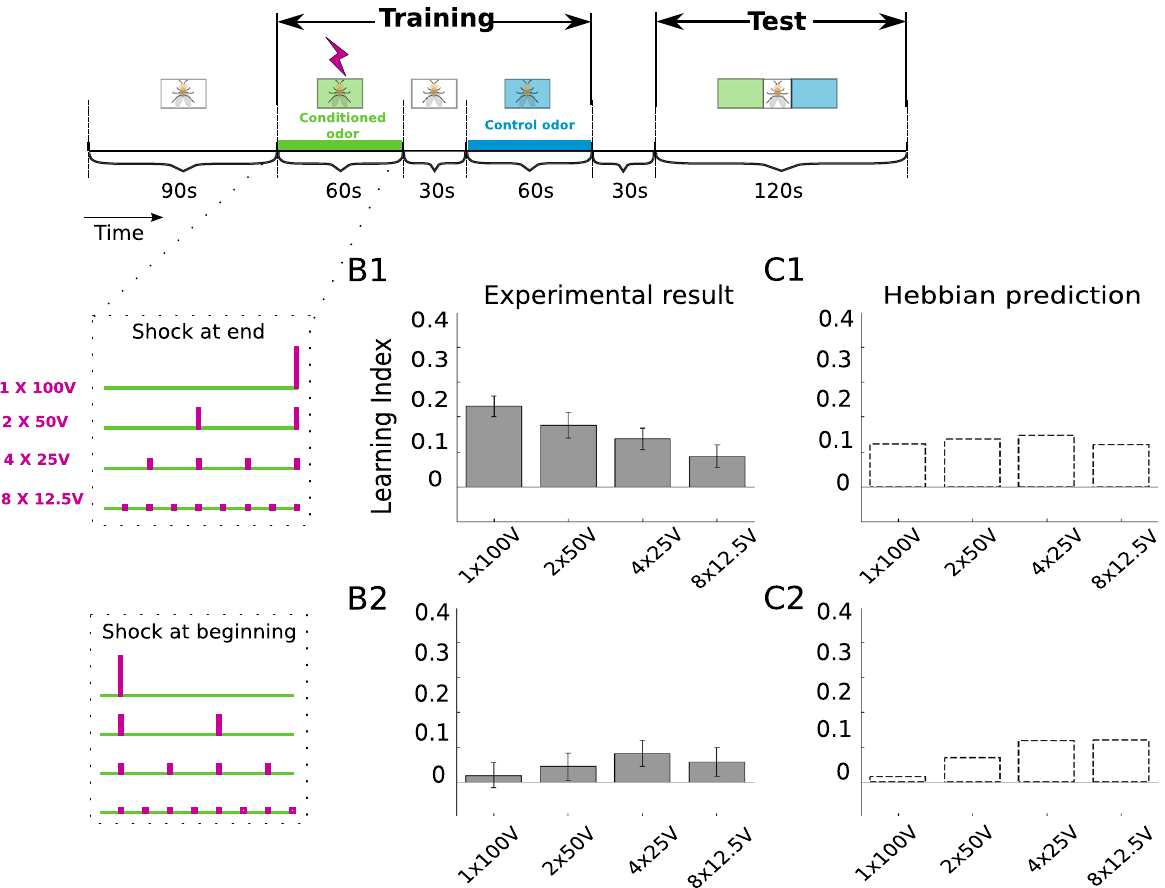
Figure 2. Temporal sequence conditioning is not fit by Hebbian plasticity. (A) Experimental protocol as explained in the main text, with total shock strength of 100 V distributed in time across the 60 s exposure to the conditioning odor (alignment towards the end, A1 , and towards the beginning, A2 ). The duration of an individual voltage shock (a magenta vertical bar) is 1.5 s. (B) Experimental results showing the LI for the corresponding shock distributions in A1 and A2 , respectively. For shocks at the end, the LI decreases with decreasing individual shock strength. Error bars represent the standard error of the mean (SEM). (C) Fit by the Hebbian plasticity, Eq. (6). For shocks at the end, a roughly constant LI is produced. For the optimized parameters we extracted S ◦ = 7 V from the minimal shock detection experiment (Fig. 2-1), τ o = 15 s from trace conditioning experiments 28 , and optimized the product αη = 0.0723